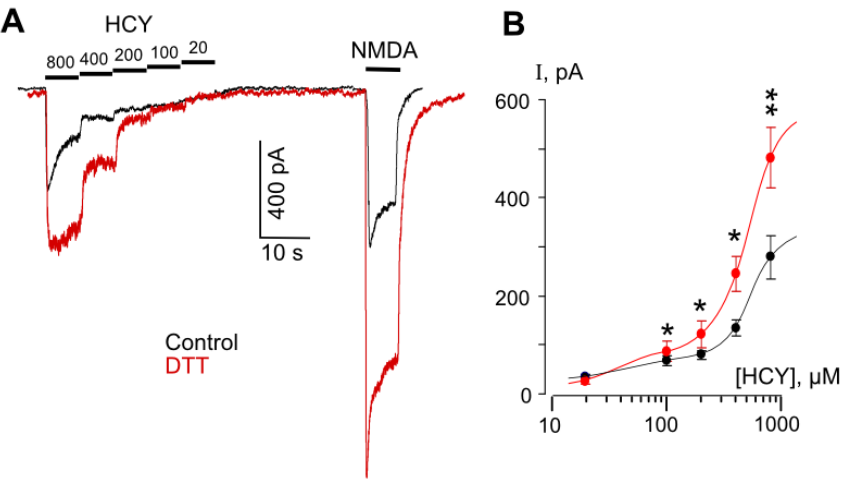
Figure 3. DTT enhances HCY- and NMDA-elicited currents in cortical neurons. ( A ) Representative currents recorded at V h = − 70 mV in neurons elicited by decreasing HCY concentrations ([HCY]) and by 100 µ M NMDA in control (black) and after treatments with 1 mM DTT for 90 s (red). Applications of agonists and values of [HCY]s are shown (in µ M) above the traces. ( B ) Concentration–activation relationships obtained under control conditions (black) and after treatment with DTT (red). Mean values ± SEM are shown ( n = 8). Data are significantly different from control p = 0.02 *, 0.01 *, 0.01 *, 0.003 ** for [HCY]s of 100, 200, 400, and 800 µ M, Student’s t -test. The curves are fitted using biphasic Hill equation.